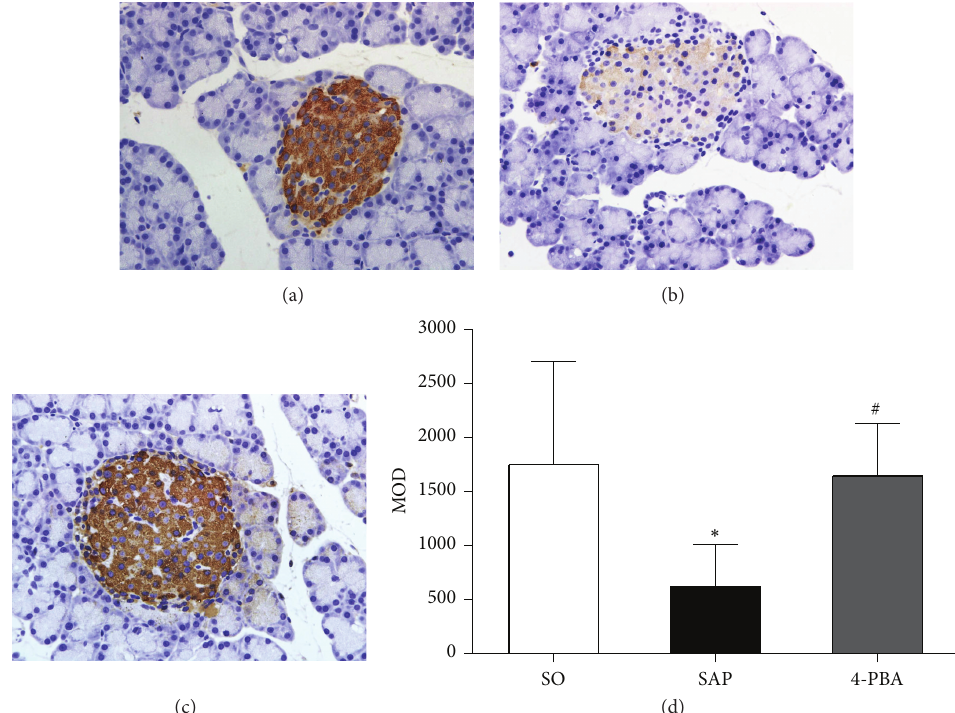
Figure 10: Immunohistochemical expression of insulin in pancreatic islets (original magnification, × 400). (a) SO group; (b) SAP group; (c) 4-PBA group. (d) Comparison of MOD of insulin in all groups. Each value represents the mean ± standard deviation. ∗ 𝑃 < 0.05 versus SO group; # 𝑃 < 0.05 versus SAP group.